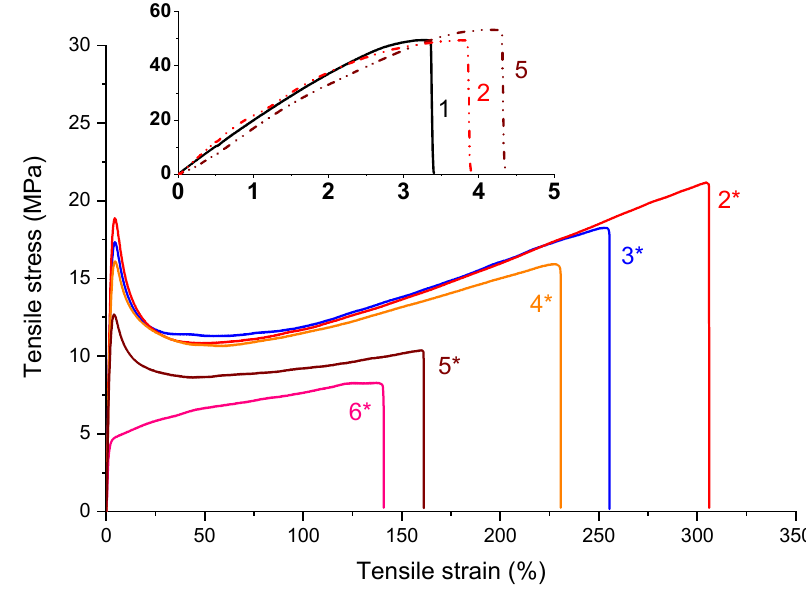
Figure 2. Stress–strain curves for PLA / PHB / ATBC filled with (2*) 1 wt %, (3*) 3 wt %, (4*) 5 wt %, (5*) 10 wt % and (6*) 20 wt % of the keratin. The inset shows the stress–strain curve of PLA / PHB blend (1) unfilled and filled with (2) 1 wt % and (5) 10 wt % of keratin. Elongation at break ( ε B ) and tensile strength ( σ M ) of PLA / PHB / ATBC / keratin composites